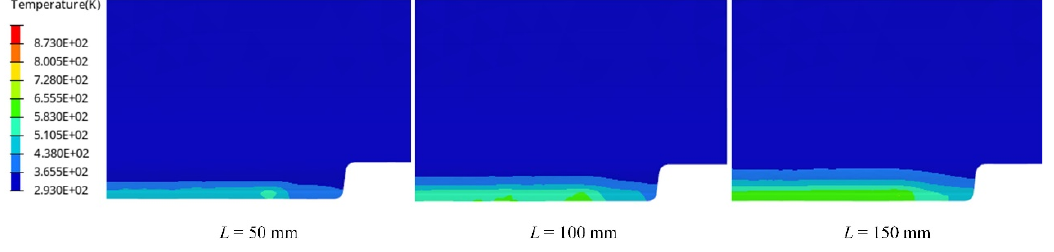
Figure 11. Tool temperature distribution of the new structure during the cutting process.